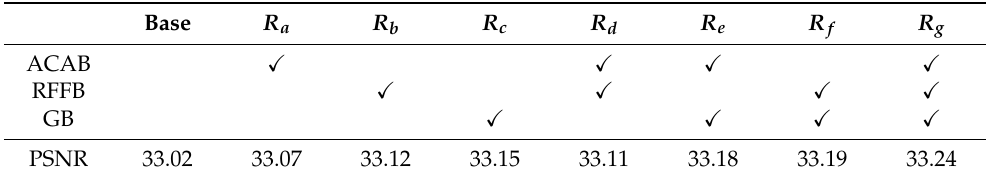
Table 3. Effects of different modules. We report the best average PSNR(dB) on Set14 (×2) in 2.5 × 10 4 iterations.